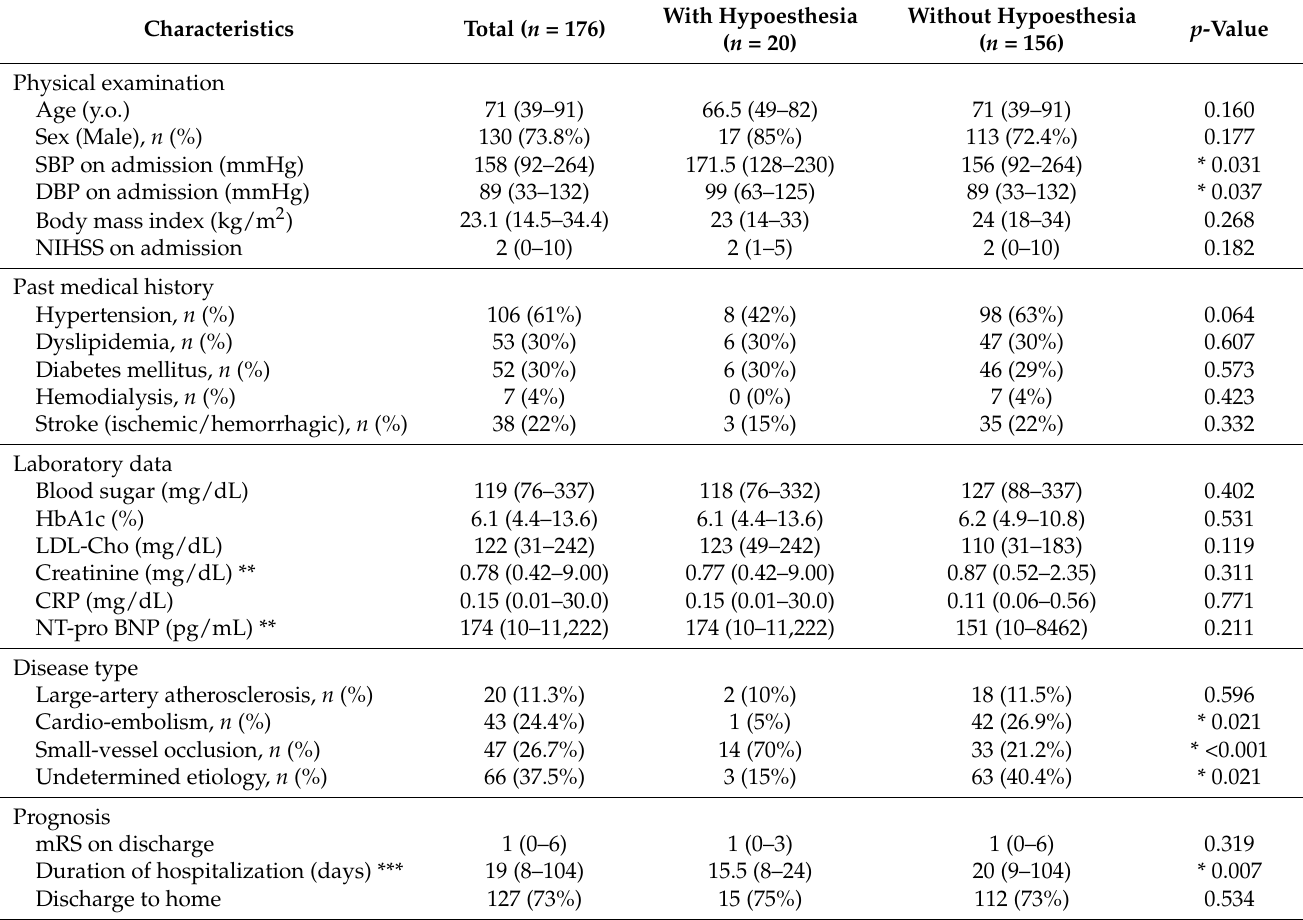
Table 2. Characteristics of the AIS patients with and without